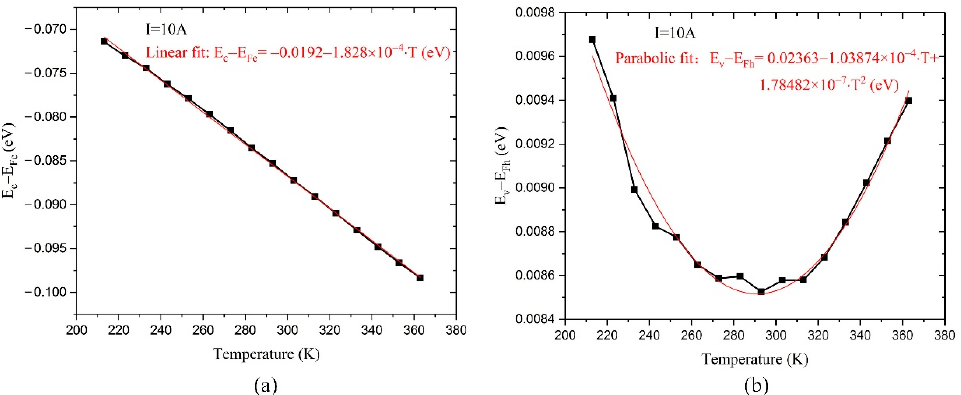
Figure 5. Temperature effects on Fermi energy level at an injection current of 10 A ( a ) electron Fermi energy level, ( b ) hole Fermi energy level.